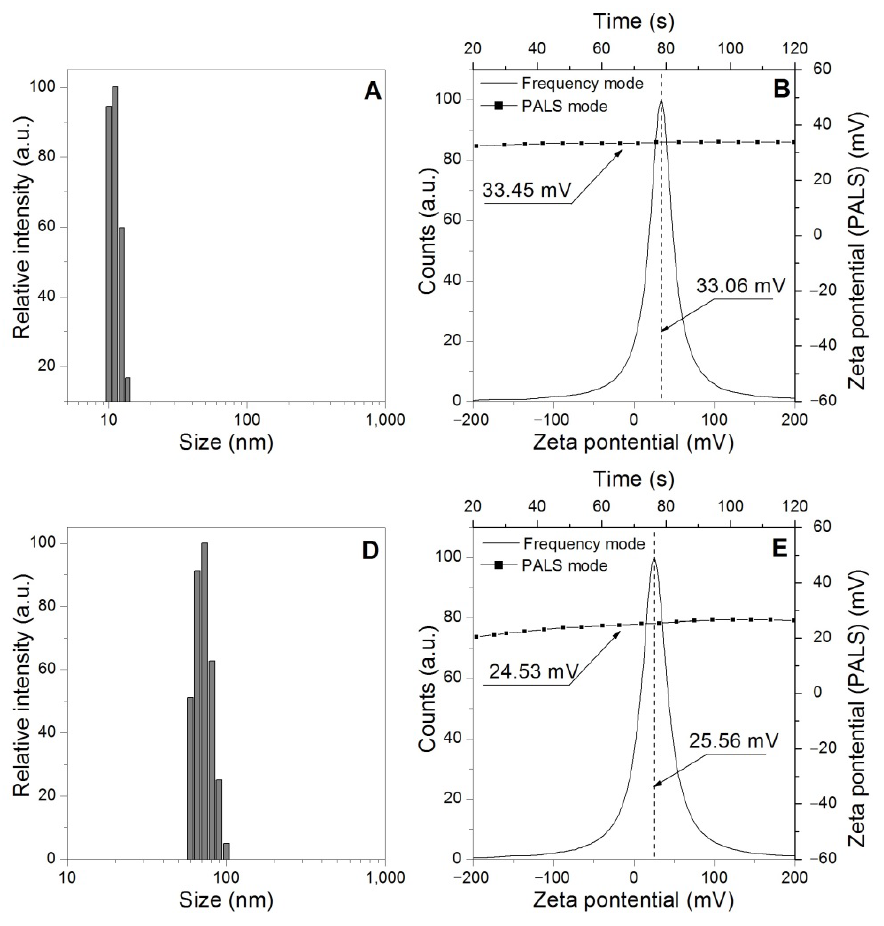
Figure 9. Dynamic light scattering particle size distribution and Zeta potential distribution of Ca(NO 3 ) 2 solution residue after of swelling process. ( A ) DLS of Ca(NO 3 ) 2 + HK. ( B ) Zeta potential of